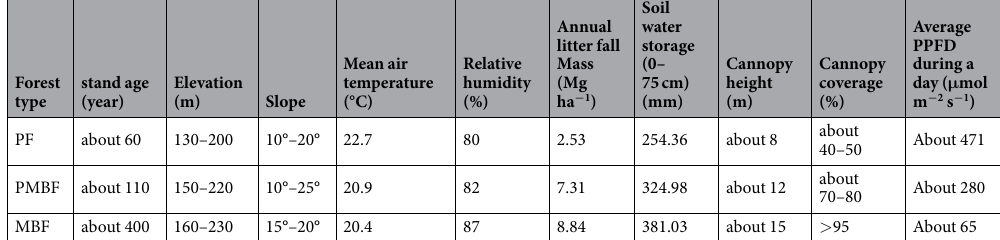
Table 1. The environmental characteristics of each successional forest community. Pine forest (PF), pine and mixed broadleaf forest (PMBF), and matured broadleaf forest (MBF), as cited from Li and Zhu et al. 27